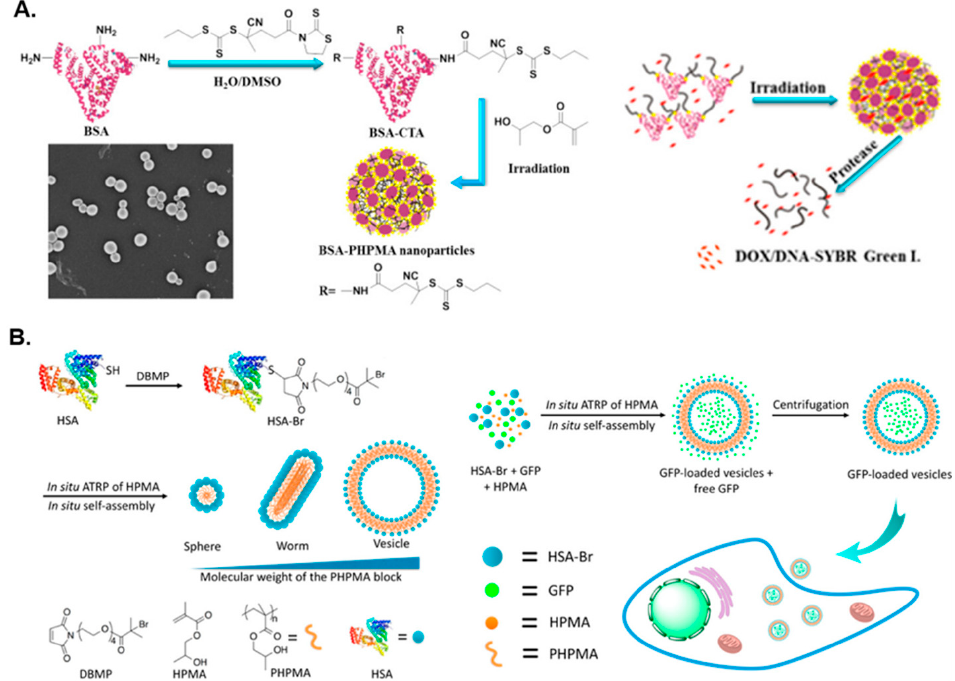
Figure 1. ( A ) Synthesis of BSA- g -PHPMA hybrid nano-objects via aqueous RAFT-mediated photo-PISA and subsequent in situ encapsulation of DOX and DNA. Adapted with permission from reference [57]. Copyright 2017 American Chemical Society. ( B ) Synthesis of HSA- g -PHPMA hybrid nano-objects via aqueous ATRP-mediated PISA and subsequent in situ encapsulation of green fluorescence protein (GFP) to form GFP-loaded vesicles. Reproduced with permission from reference [58]. Copyright 2017 American Chemical Society.